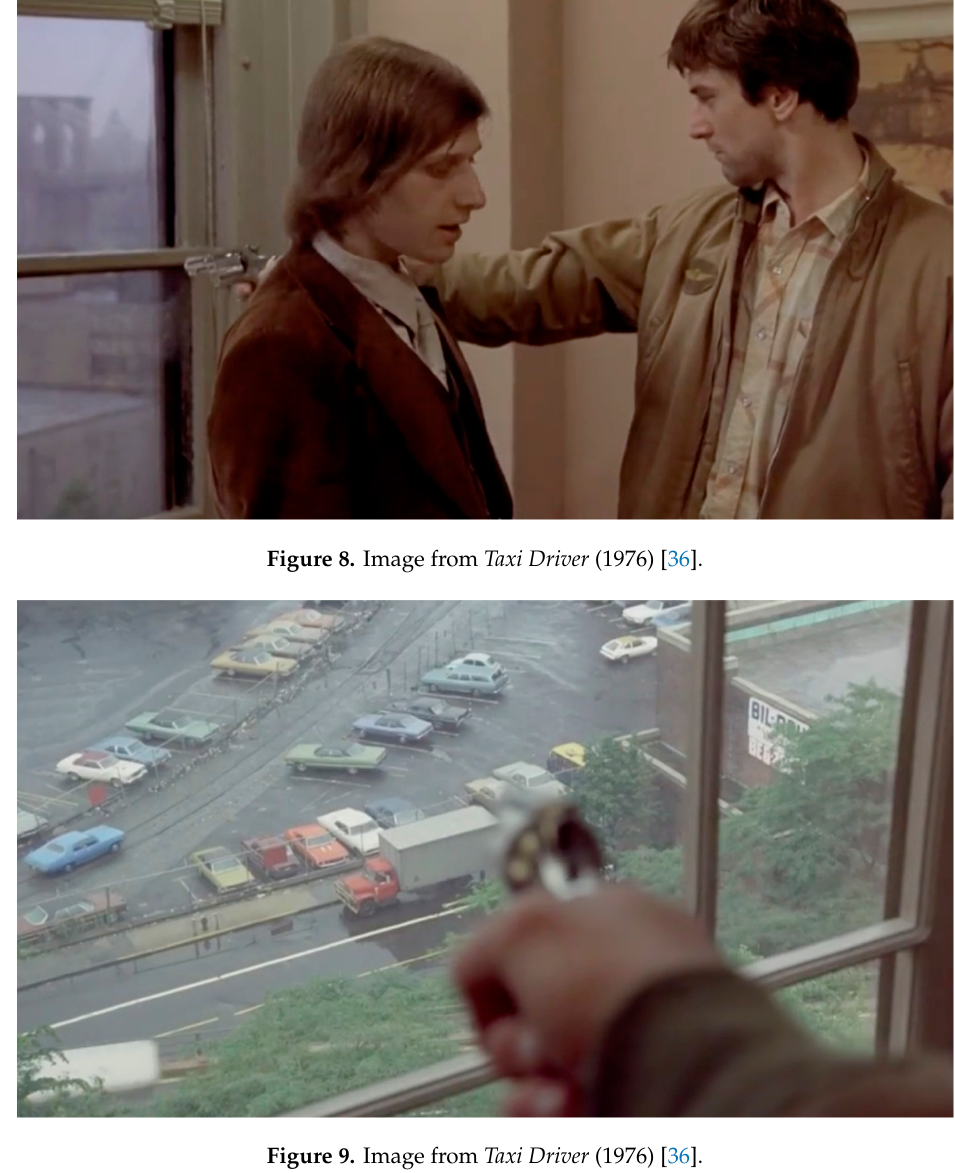
Figure 9. Image from Taxi Driver (1976) [36].